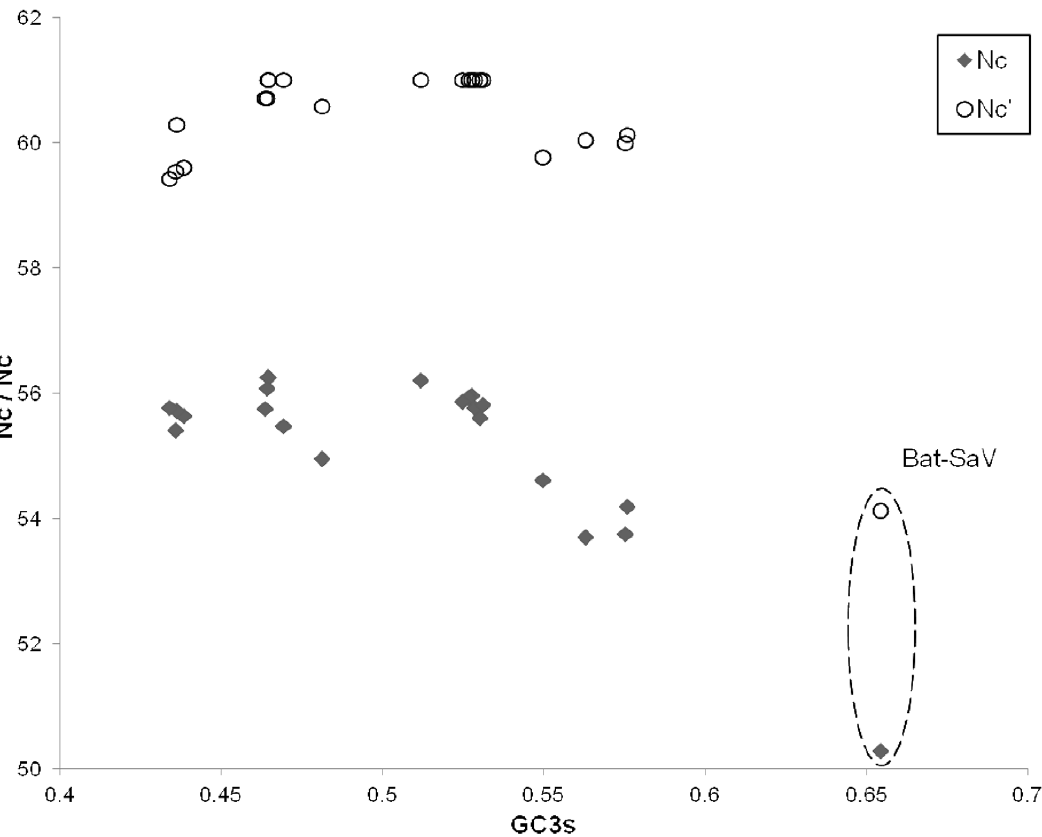
Figure 4. Scatterplot of codon usage. The scratterplot of codon usage summary statistics N c and N c 9 against the proportion of G or C nucleotides at the 3 rd position of synonymous codons (GC 3s ), showing greater codon usage bias in the bat SaV genome relative to other SaV genomes. Unlike the porcine enteric caliciviruses, the observed difference in codon usage bias persists with adjustment of background nucleotide composition (N c 9 ).